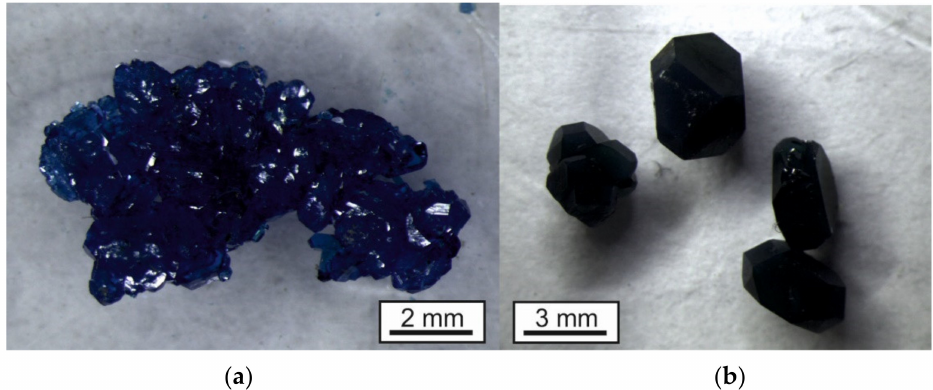
Figure 6. Crystals of chalcomenite, CuSeO 3 · 2H 2 O, grown by a reaction between 0.3 m CuCl 2 in gel and 1 m H 2 SeO 3 supernatant solution in both cases: ( a ) Finer crystals formed on top of silica gel; ( b ) Coarse well-developed crystals formed within a 1% agar